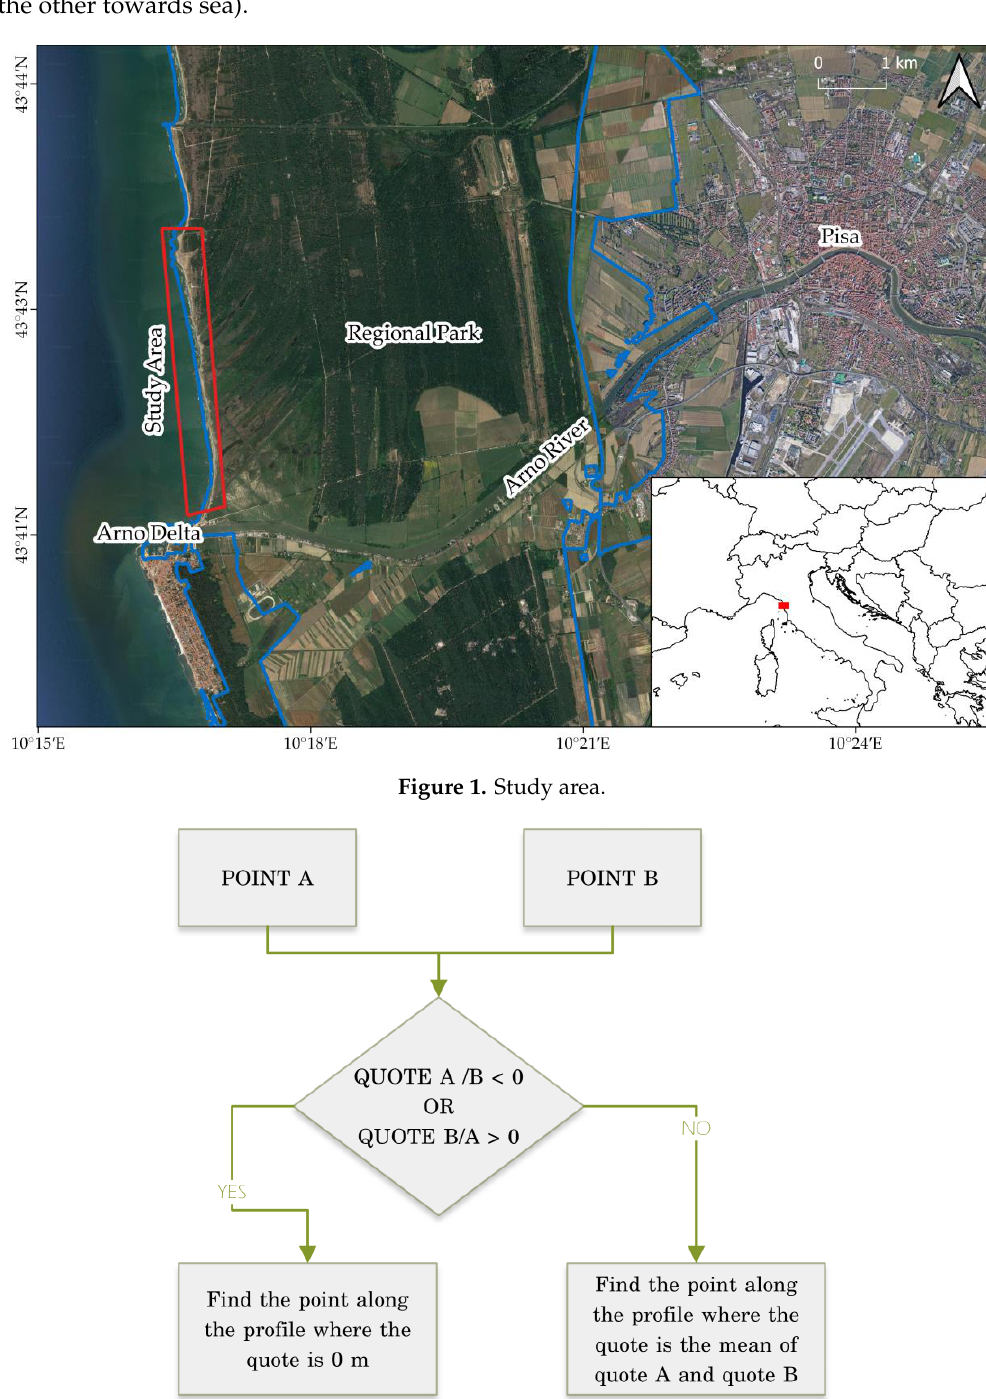
Figure 2. Flowchart of the algorithm designed for identification of the shoreline using differential GPS (DGPS) points.